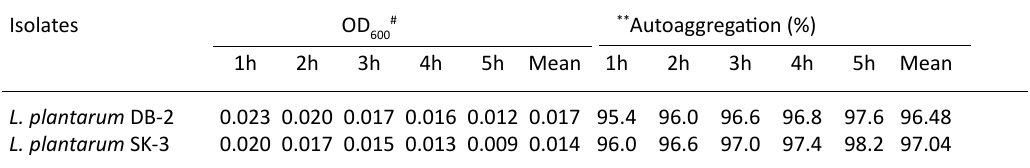
Table 6. Estimation of auto-aggregation of selected Lactobacillus strains Isolates OD 600#